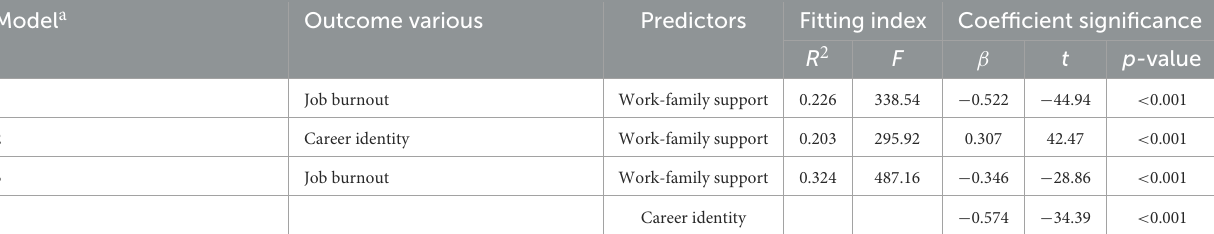
TABLE 3 Model testing of